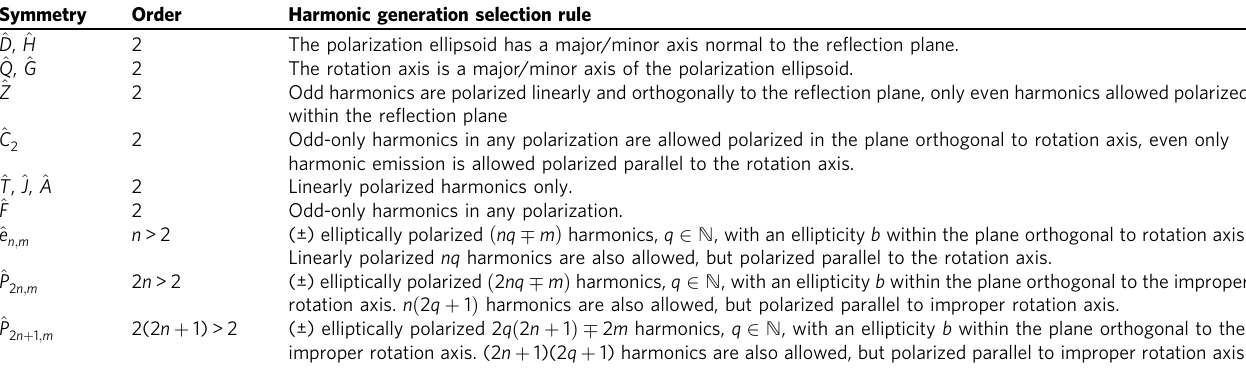
Table 2 (3 + 1)D DSs and their associated selection rules for collinear or non-collinear atomic/molecular/solid HG Symmetry